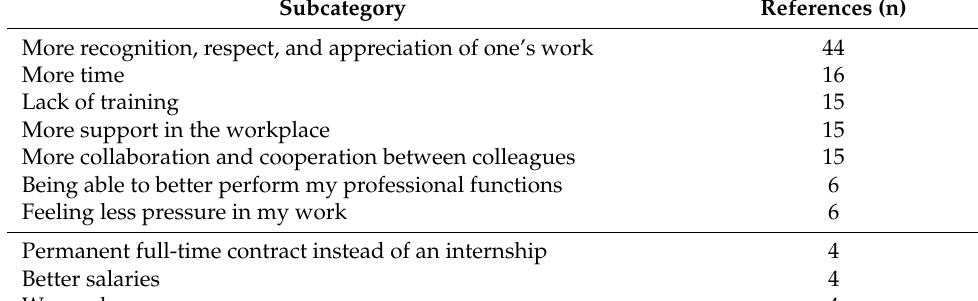
Table 10. Analysis of category 5. The feeling—or lack thereof—of fulfilment as a teacher. Subcategory References